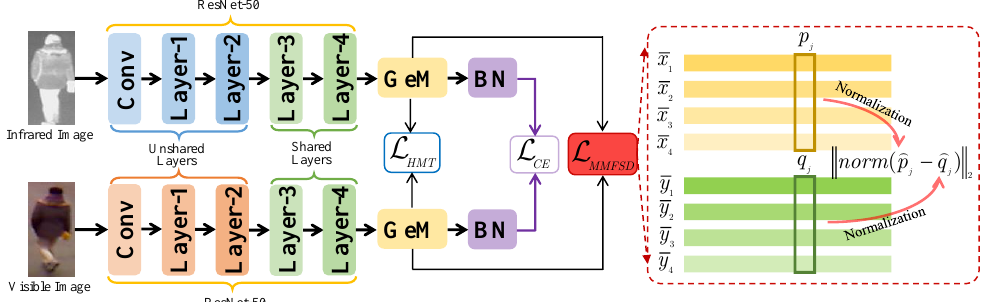
Figure 2. The overall framework of visible-infrared person